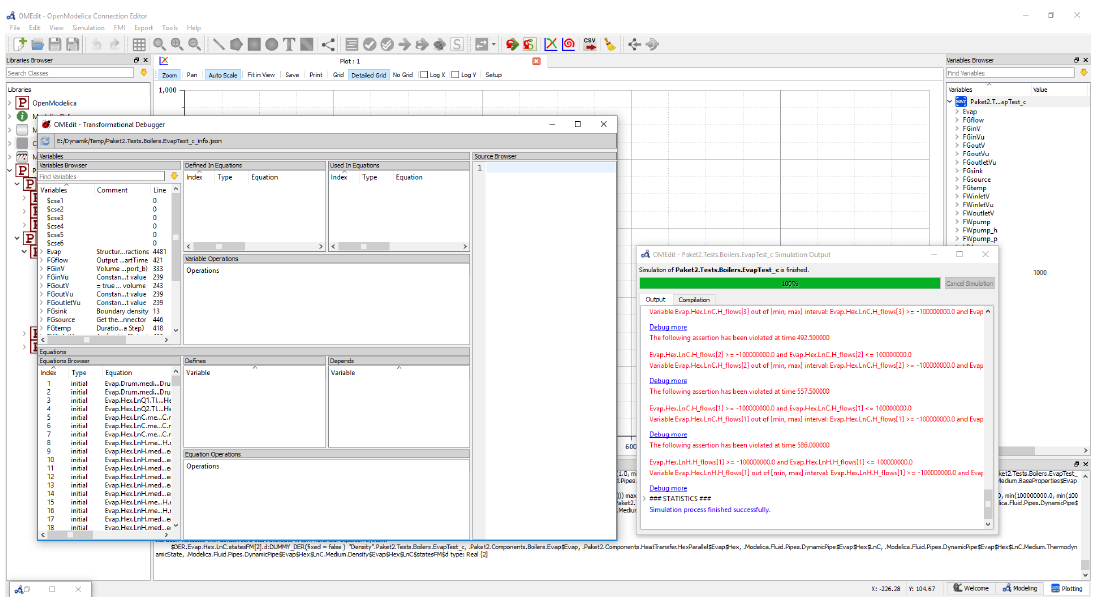
Figure 5: Information from OpenModelica with debugger activated at successful simulation